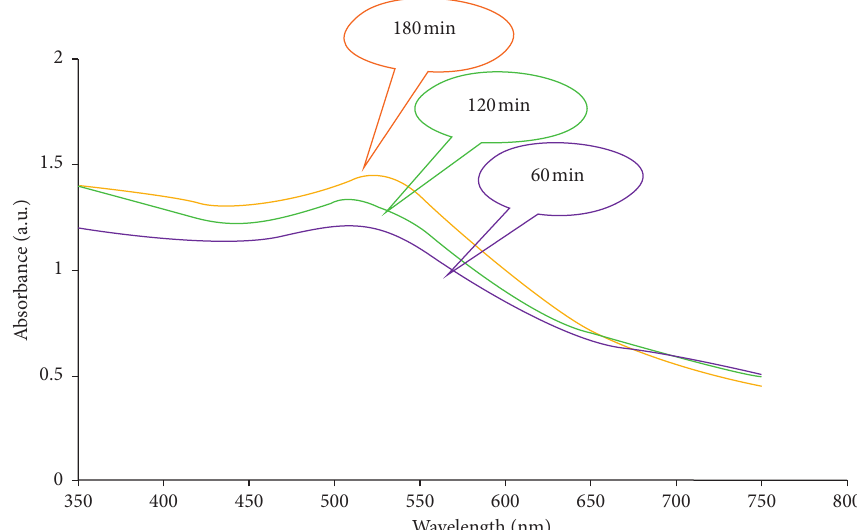
Figure 4: UV-Vis absorption spectrum of CuNP biosynthesis at different time intervals.